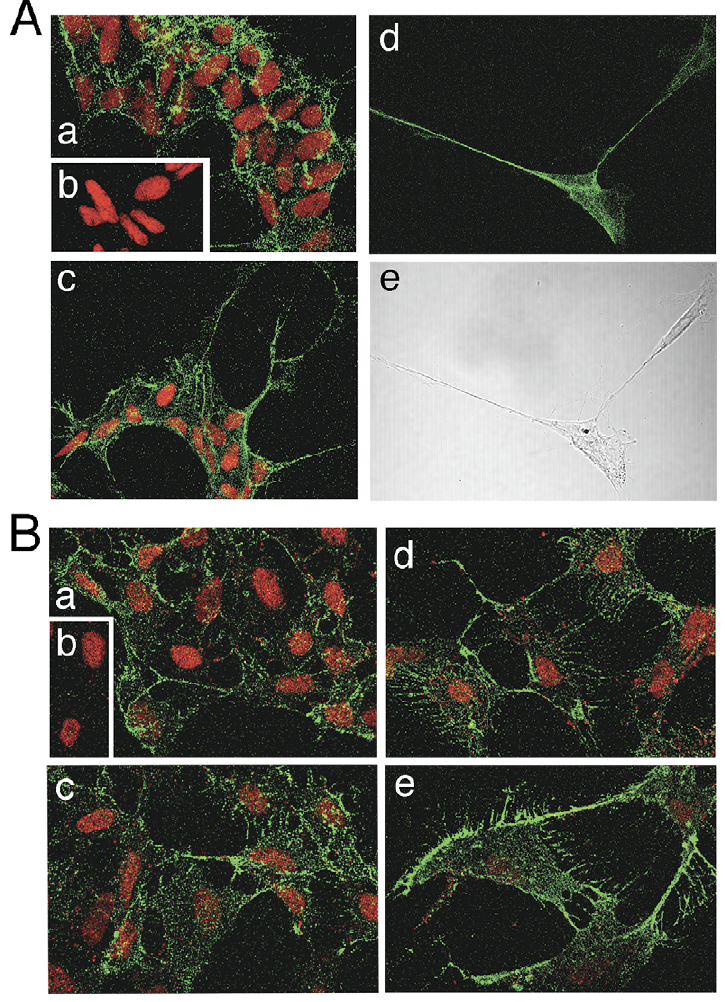
Fig. 4. ALCAM expression and localization in differentiated SH-SY-5Y (A) and SK-N-BE (B) NB cells. Untreated cells (a) and cells treated for 48 h (b, c), 5 (Bd) or 7 days (Ad, Ae and Be) with 10 µM ATRA were stained with the anti-ALCAM I/F8 scFv (a, c, d, Be) or with isotype matched control (b) followed by Alexa488-conjugated goat anti-mouse. In Ae, phase contrast image of the same field as in Ad is shown. Nuclei were counterstained with propidium iodide. Immunofluorescence was visualized by confocal microscopy (original magnification 600 ×